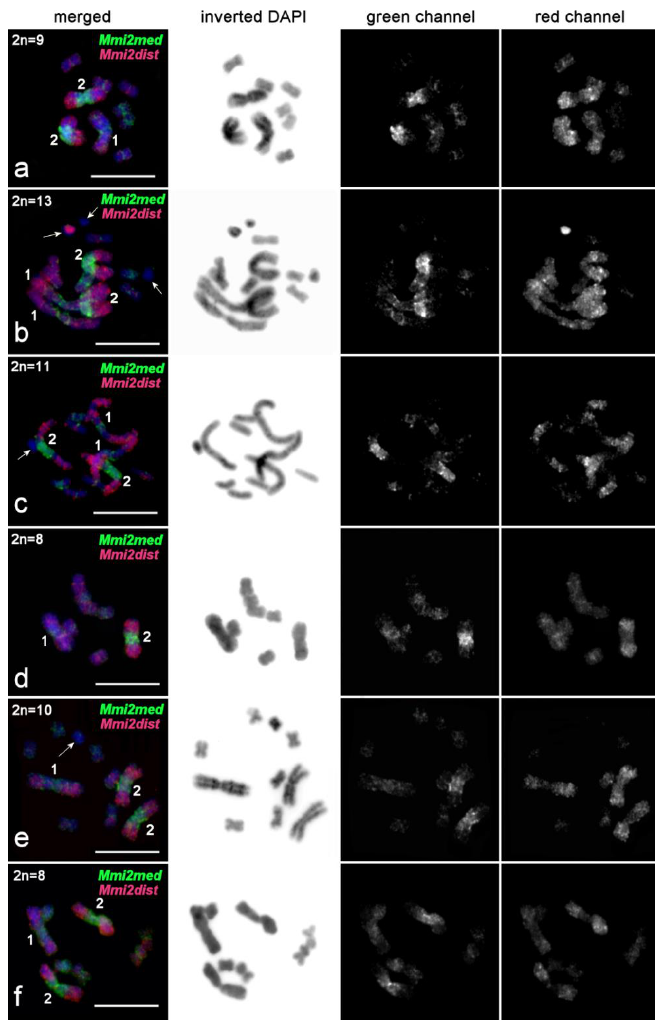
Figure 7. FISH with microdissected region-specific DNA probes derived from chromosome MMI2 of M. mirumnovem on chromosomes of the original species . Separate channels ( Mmi2med , green signal; Mmi2dist , red signal) and merged images are shown. FISH was performed on metaphase plates with different chromosome numbers. B chromosomes are shown by arrows. ( a ) 9, − MMI1; ( b ) 13,+3B (four large and six small metacentrics, and three B chromosomes); ( c ) 11,+1B (four large and six small metacentrics, and one B chromosome); ( d ) 8, − MMI1, − MMI2 (two large and six small metacentrics); ( e ) 10, – MMI1,+1B (three large and six small metacentrics, and one B chromosome; ( f ) 8, − MMI1, − MMI4 (three large, and five small metacentrics). Chromosomes were counterstained with DAPI (blue). Scale bar 10 µm .